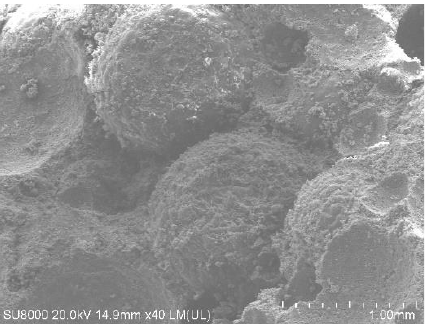
Figure 10. SEM Morphology of CLSM after EVA modified EPS.